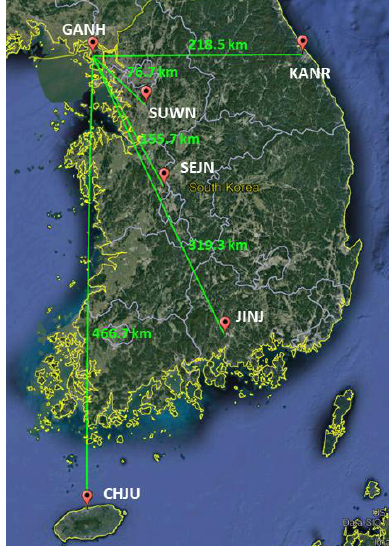
Figure 2. Locations of the six reference stations of NGII in Korea.